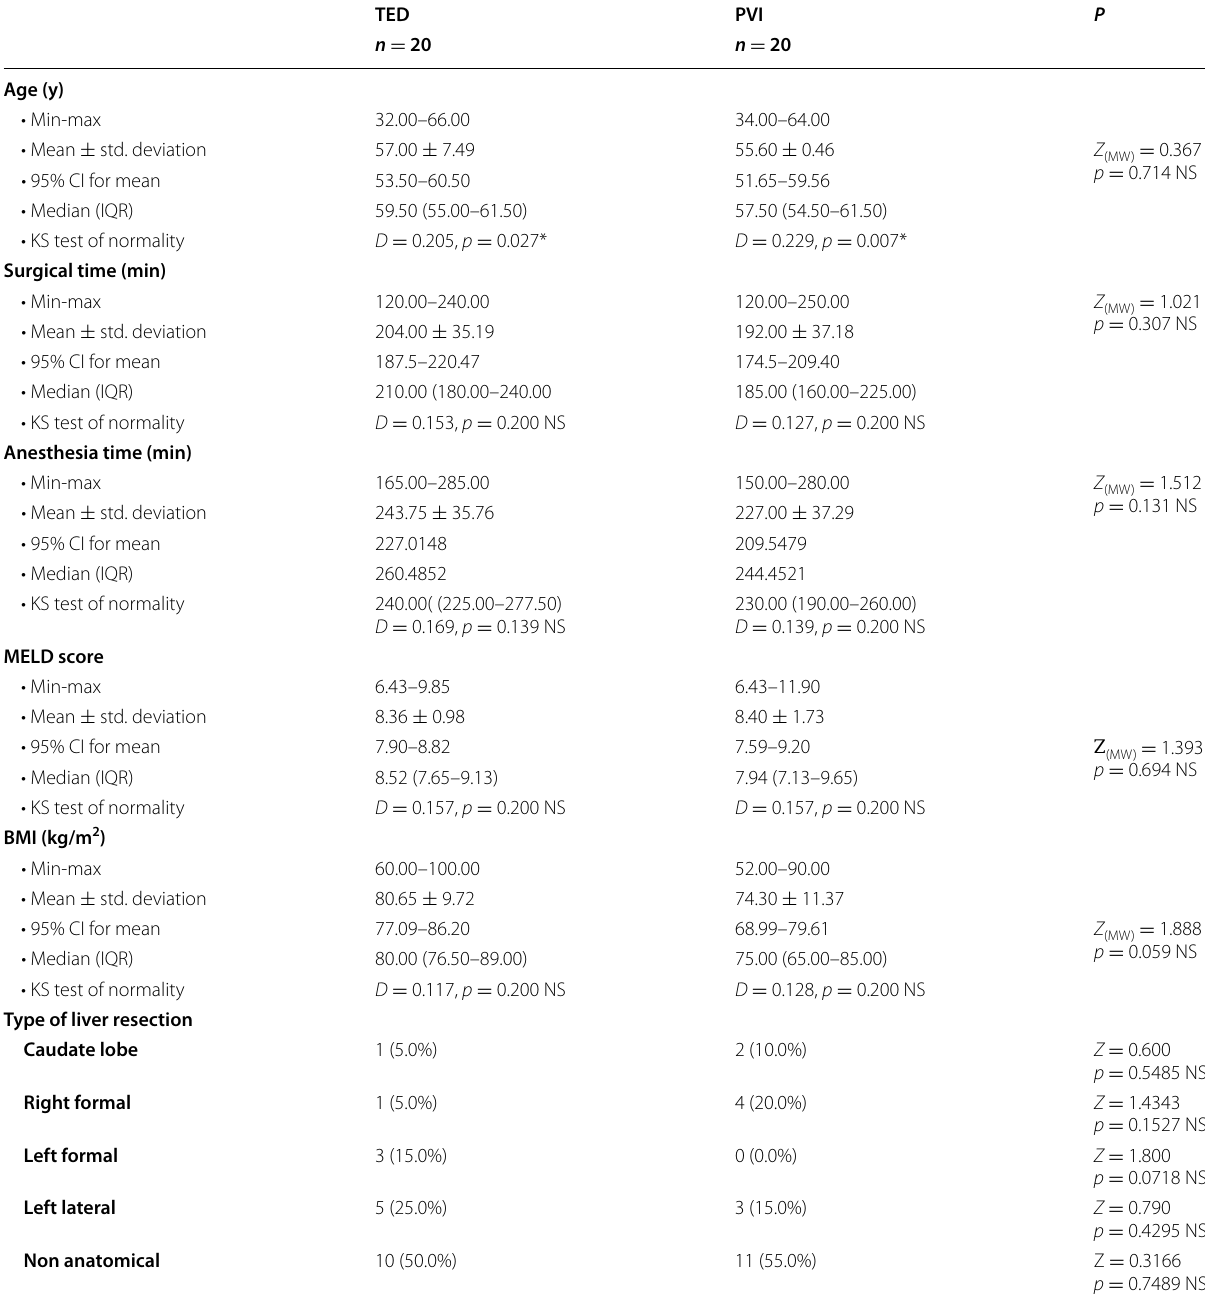
Table 1 Patients’ clinical and operative characteristics of transesophageal Doppler (TED) compared to plethysmography